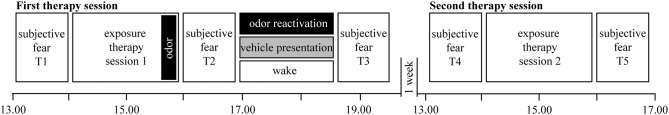
Procedure. Patients came to two therapy sessions separated by 1 week. At the end of the first therapy session, verbalized subjective therapy success was associated with an odor. Thereafter, patients slept or stayed awake. For the sleep groups, we presented the odor or an odorless vehicle during non-rapid eye movement (NREM) sleep. Fear was measured at five different time points: as baseline before the first exposure therapy (T1), after the first exposure therapy session (T2), after the sleep or wake interval (T3), before the second exposure therapy (T4), and after it (T5).